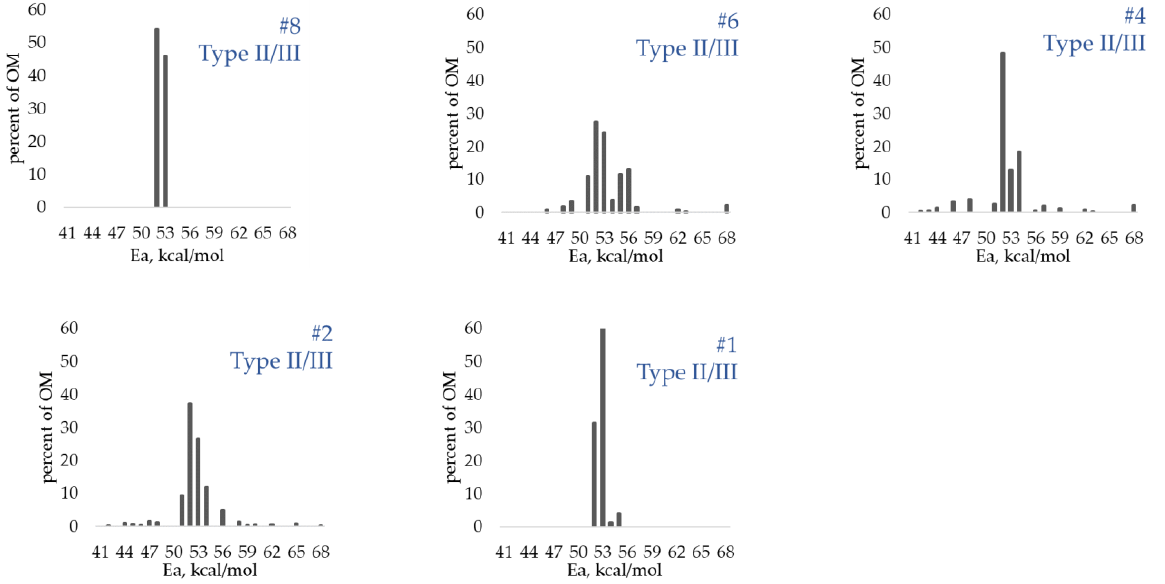
Figure A1. Representative bulk kinetic spectra (A = 1 · 10 14 s − 1 ) of kerogen decomposition for low TOC members #1, #2, #4, #6, #8.